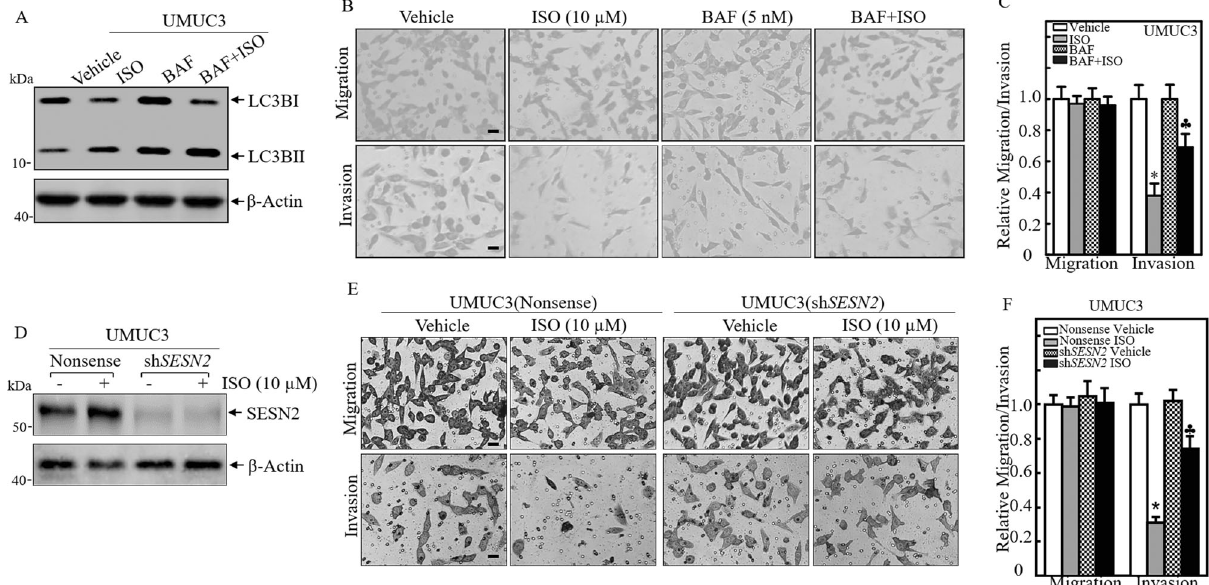
Fig. 2 SESN2-dependent autophagy-mediated ISO inhibition of human BC cell invasion. A UMUC3 cells were treated with ISO (10 μ M), with or without BAF (5 nM) for 24 h, and the cell extracts were subjected to Western blot for determining of conversion of LC3B I to LC3B II. B , C Representative images of migration and invasion of UMUC3 treated with 10 μ M ISO, 5 nM BAF or both in cellular migration and invasion assay were captured under a microscope ( B ). The invasion and migration cells were counted at least three random fi elds under a light microscope and the migration (Transwell) and invasion rates were calculated as relative to vehicle control as described in the “ Materials and Methods ” section. The bars indicate Mean ± SD from three independent experiments. * Signi fi cant decrease from vehicle control ( p < 0.05), ♣ Signi fi cant increase from ISO-treated alone ( p < 0.05). D The indicated stable transfectants were subjected to Western blot for determination of SESN2 expression with or without 10 μ M of ISO treatment for 24 h in UMUC3 cells. E , F The stable transfectants, UMUC3(sh SESN2 ), were used for determination of their abilities of cell invasion and migration as compared with their vector control transfectants as described above. The bars indicate Mean±SD from 3 independent experiments. * Signi fi cant decrease from UMUC3(Nonsense) treated with vehicle control ( p < 0.05). ♣ Signi fi cant increase from UMUC3 ( Nonsense) treated with ISO alone ( p <